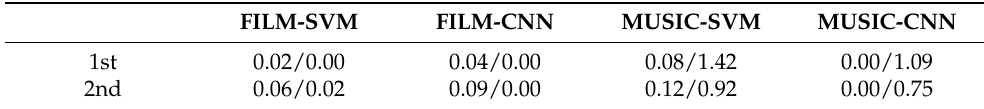
Table 2. FAR and FRR for intra-dataset evaluation (%).